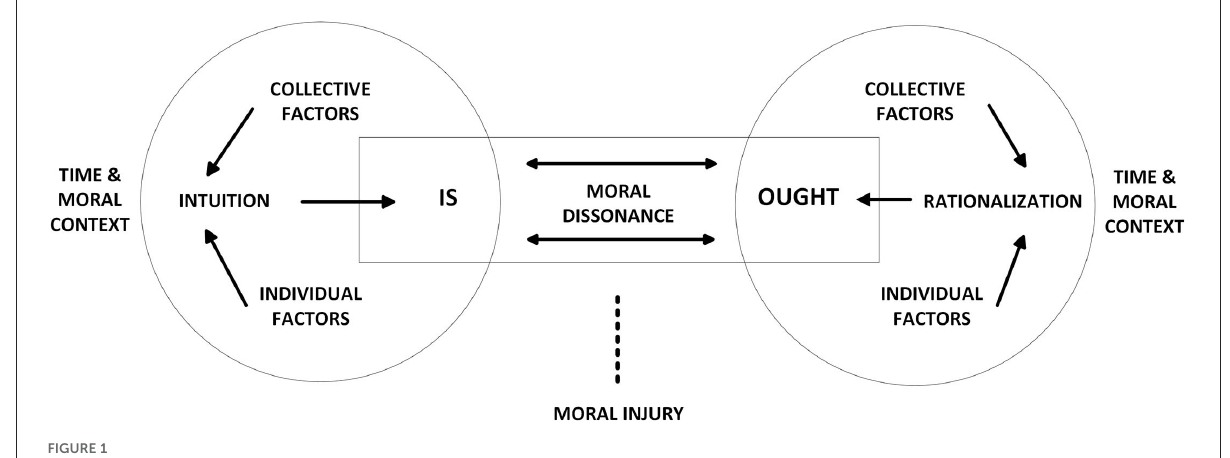
FIGURE1 The Moral Dissonance